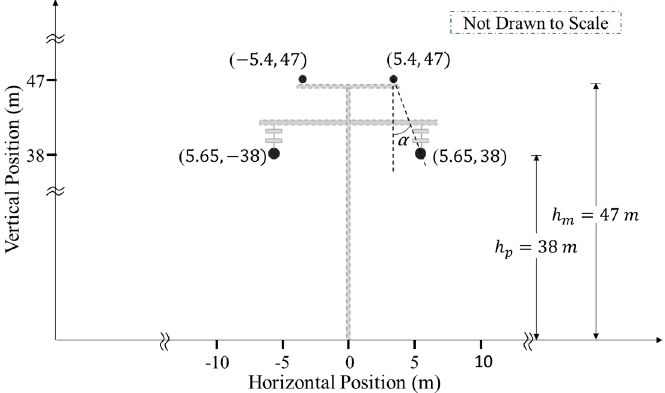
Figure 5. Geometric model of tower for application of an electro-geometric model (EGM) to calculate the shielding failure current ( I MSF